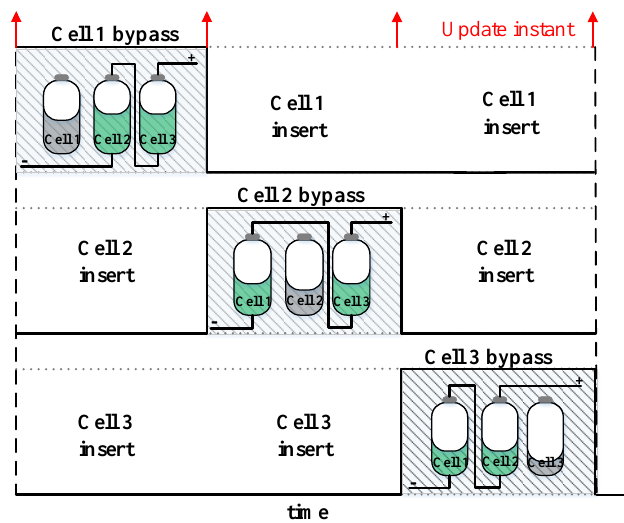
Figure 5. The balance process in the smart battery pack.